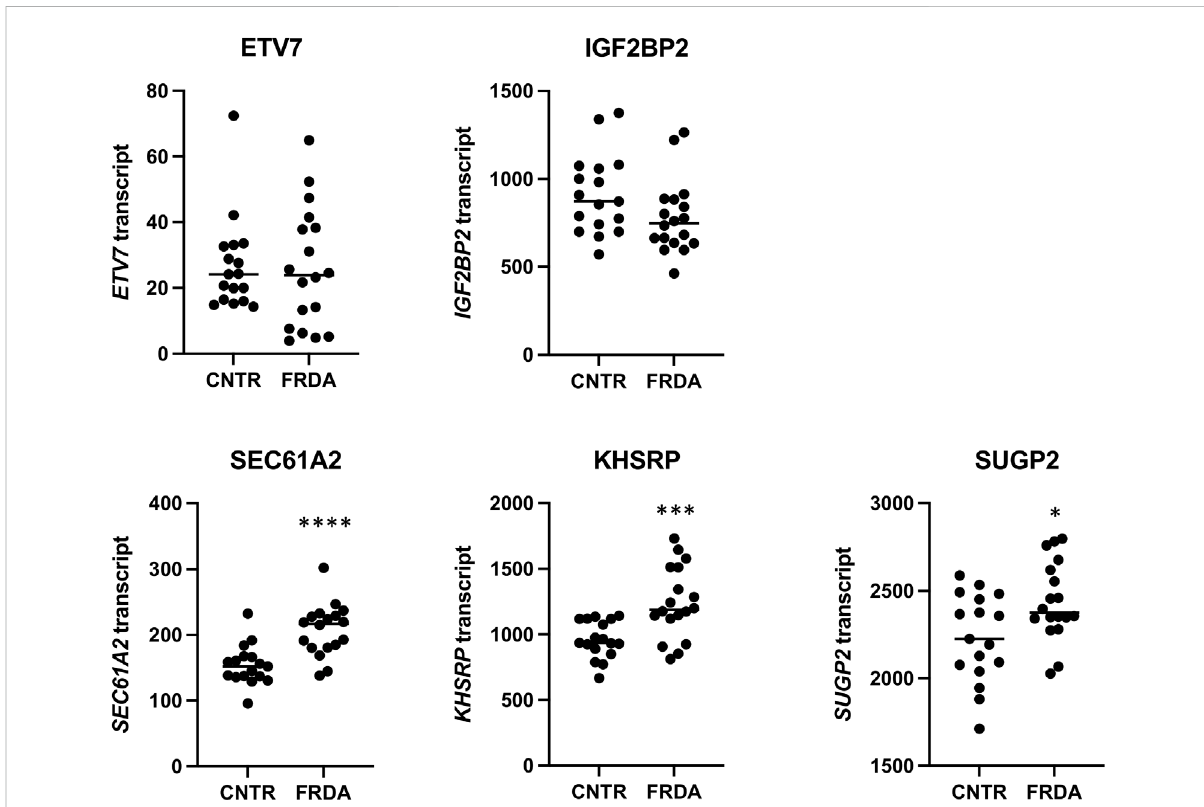
FIGURE 3 Relative mRNA values from a publicly available RNA-seq data set for the fi ve DE genes found in the iPSC-neuron analysis (ETV7, IGF2BP2, SEC61A2, KHSRP, and SUGP2) shown in non-FRDA control (CNTR) fi broblasts and FRDA fi broblasts. * = p < 0.05, *** = p < 0.001, and **** = p <